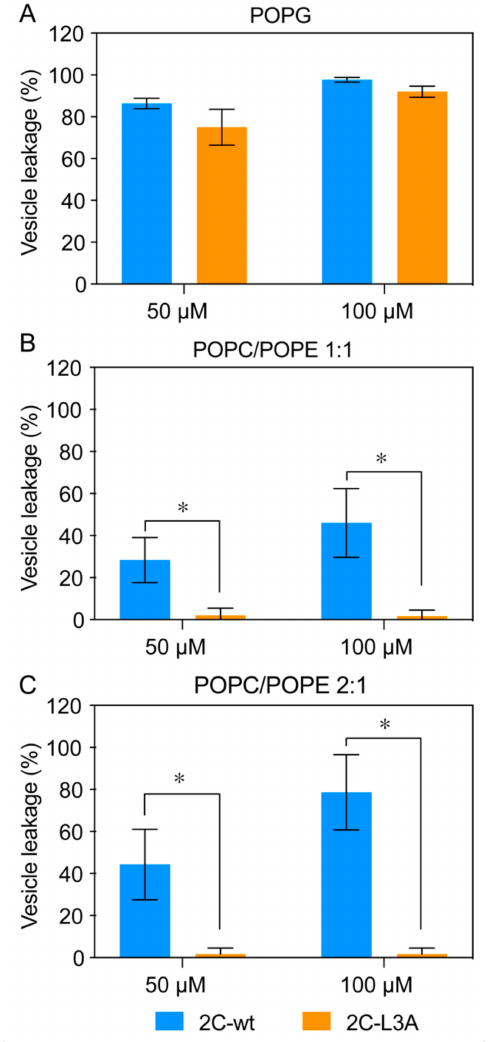
Figure 7. Vesicle leakage induced by 2C peptides. A significantly higher amount of leakage is observed with 2C-wt compared to 2C-L3A. POPG ( A ), POPC / POPE 1:1 ( B ), or POPC / POPE 2:1 ( C ) vesicles were incubated with 2C-wt (blue) or 2C-L3A (orange) peptides. The concentrations of peptides were tested at 50 and 100 µ M. Lipid vesicles were used at 500 µ M concentration. Data are represented as the mean ± SE of three independent experiments. *, p < 0.05 (paired Student’s t